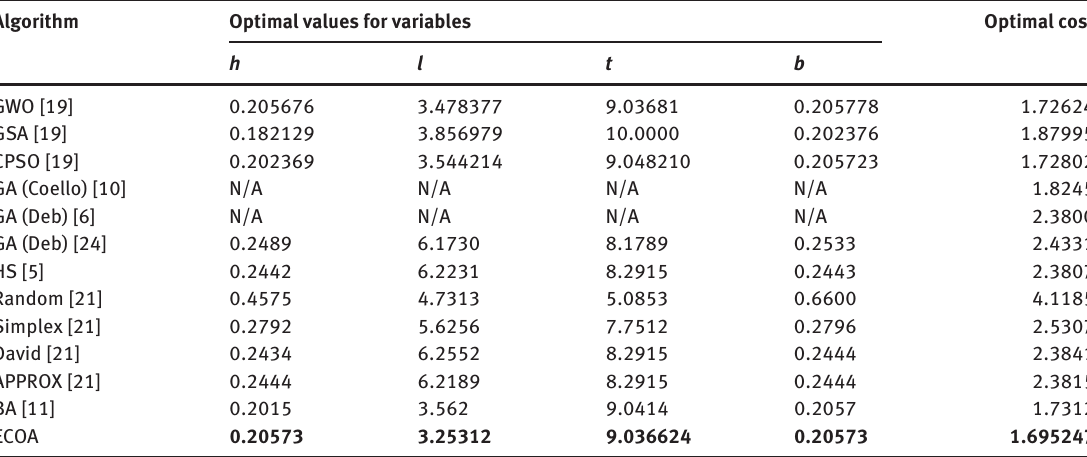
Table 8: Comparison Results for the Welded Beam Design